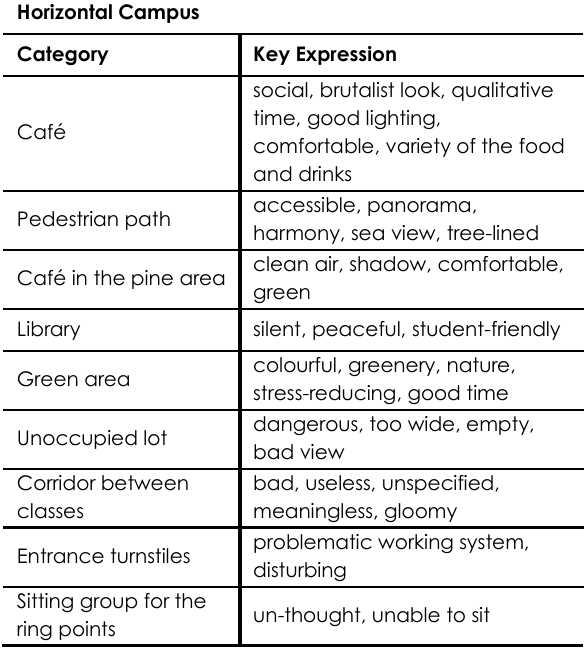
Table 8. Categories and key expressions of subjects for photography on horizontal